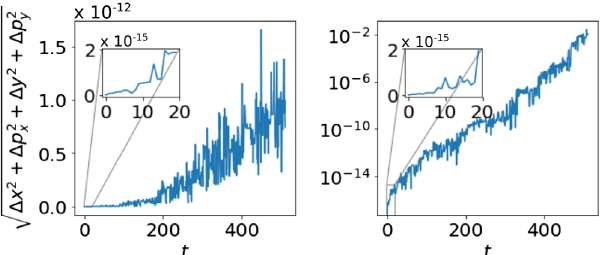
FIG. 3. Differences after forward-backward tracking for various times t . Each orbit starts from x ¼ 0 . 0 , y ¼ − 0 . 15 , and p with p determined by the condition H ¼ E . Here E ¼ 1 = 12 x (left) or E ¼ 1 = 9 (right). Notice that the vertical scale in the rightmost figure is logarithmic. A second order symplectic integrator with time step dt ¼ 10 − 3 is used to track particles.